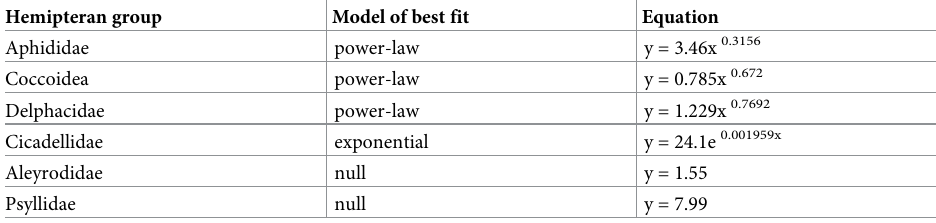
Table 2. Equations for the model of best fit from Method 1 for different hemipteran families (see Fig 1 and S3 Appendix) where the amount of honeydew produced (y) is a function of body mass in μg (x) for a given family. Hemipteran